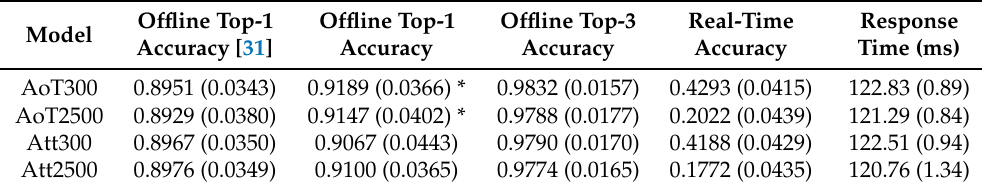
Table 3. Offline and real-time results in terms of classification accuracy. The table shows the average across subjects and the standard deviation in parentheses. An ‘*’ denotes a significant difference (p-value < 0.05) between the top-1 accuracy in [31] and the current study.